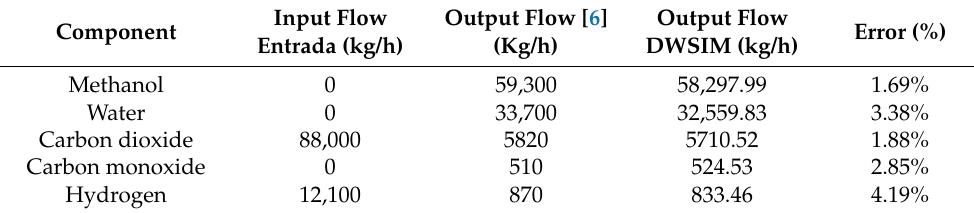
Table 7. DWSIM simulation validation.